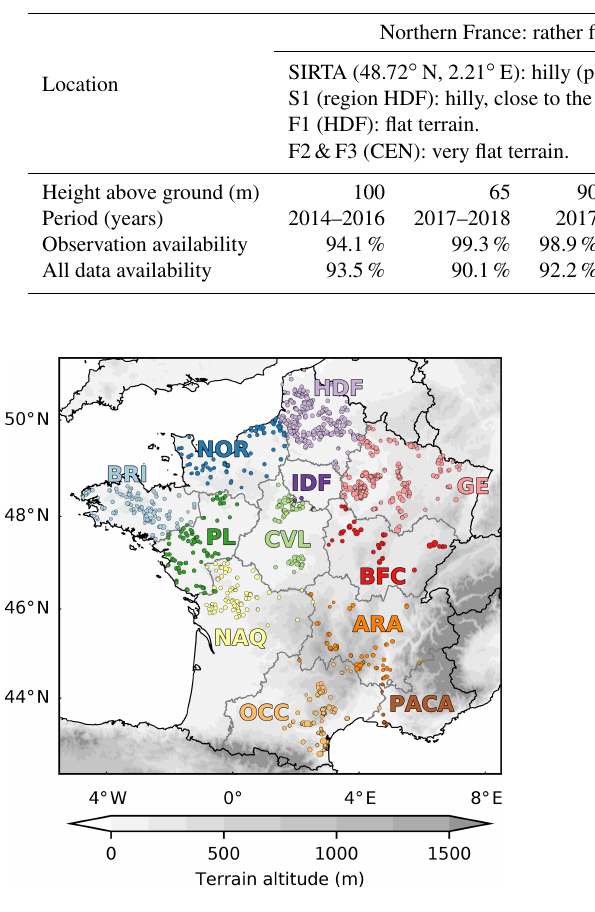
Figure 2. Map of continental France: wind farms installed by the end of 2017 (dots) with colours depending on the administrative region (annotated acronyms, see full names in Sect. 2.3) and orog- raphy (grey